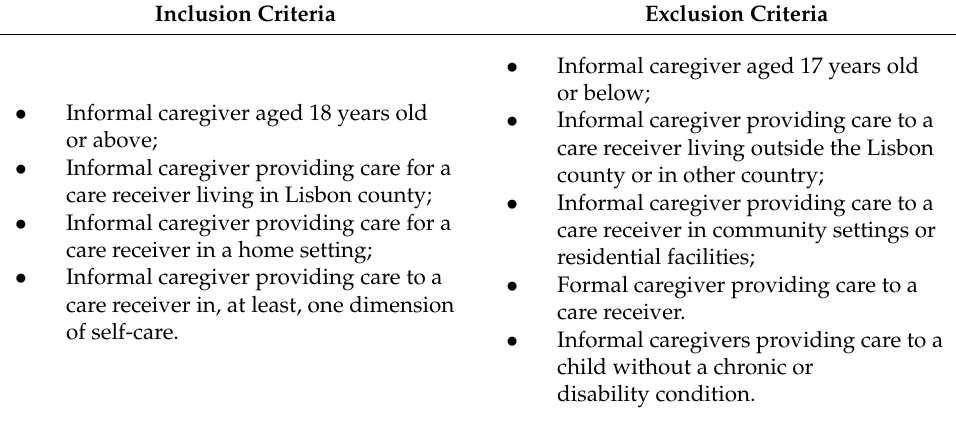
Table 1. Inclusion and exclusion